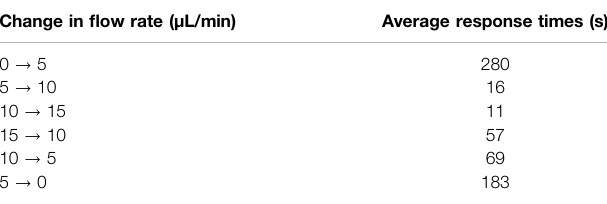
TABLE 4 | Flow Control Average Response Times for each step (n (cid:2)